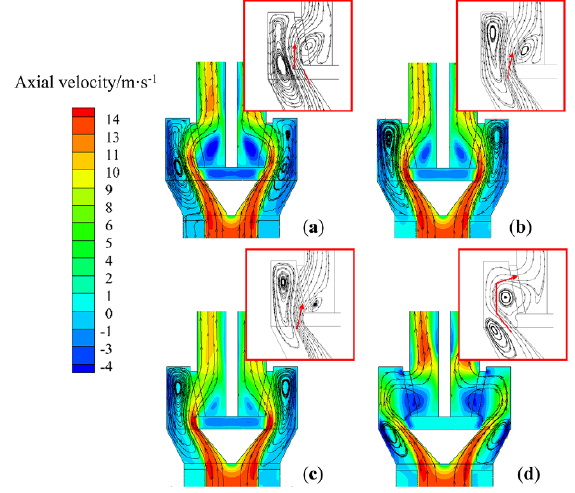
Figure 22. Effect of the diameter of the diversion cone on the axial velocity and gas movement (T-C (1-0.8) , x = 0): ( a ) d = 176 mm, ( b ) d = 198 mm, ( c ) d = 220 mm, and ( d ) d = 242 mm.